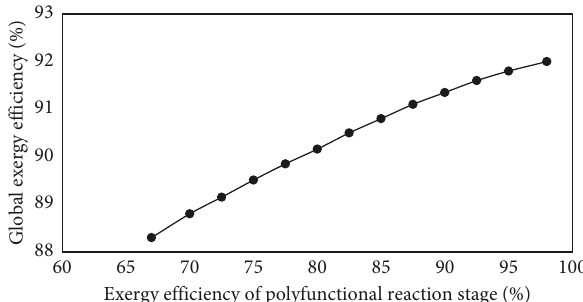
Figure 6: Effect of the polyfunctional reaction stage efficiency on global exergy efficiency.